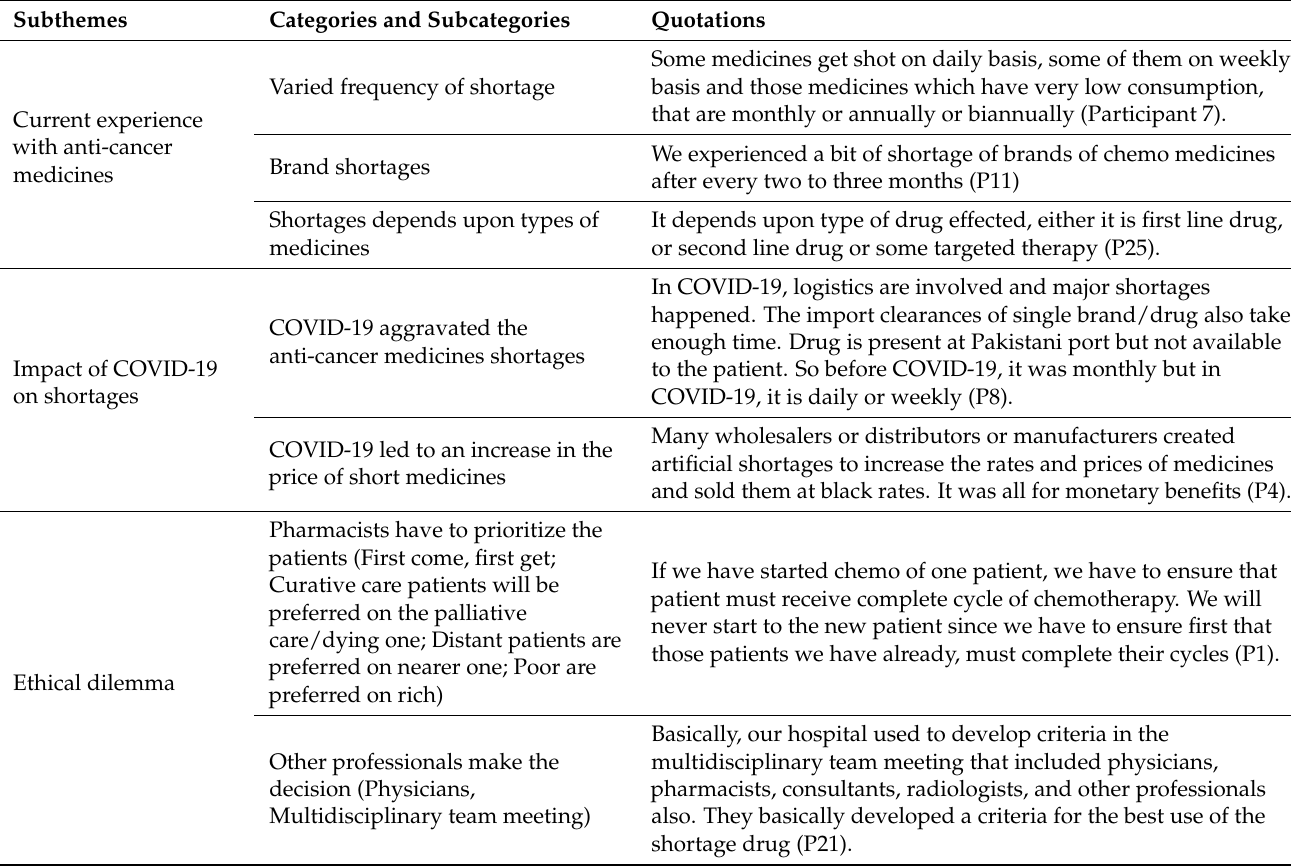
Table 2. Theme 1: Dynamics and perception of anti-cancer medicines